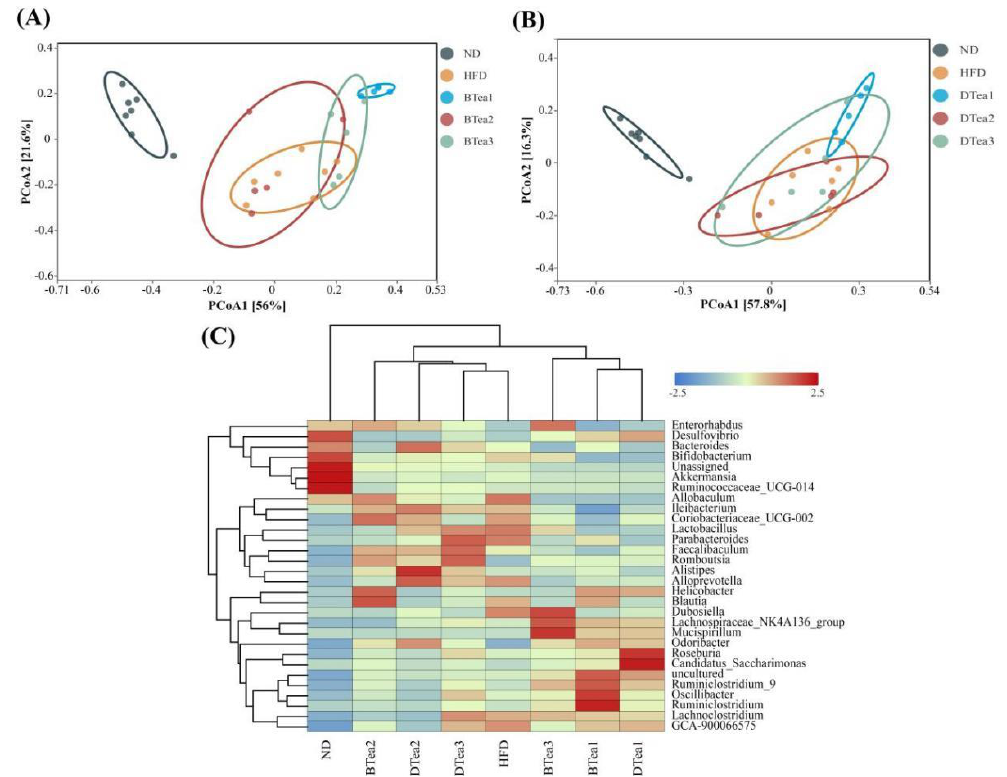
Figure 7. The effects of different black and dark teas on the gut microbiota structure. ( A ) PCoA analysis among ND, HFD and black teas groups; ( B ) PCoA analysis among ND, HFD and dark teas groups; ( C ) species abundance cluster analysis at the genus level. ND, the control group (normal diet group); HFD, the model group (high-fat diet group); BTea1, selenium-enriched black tea; BTea2, Dianhong tea; BTea3, Yingde black tea; DTea1, Fu brick tea; DTea2, Liupao tea; DTea3, selenium-enriched dark tea.